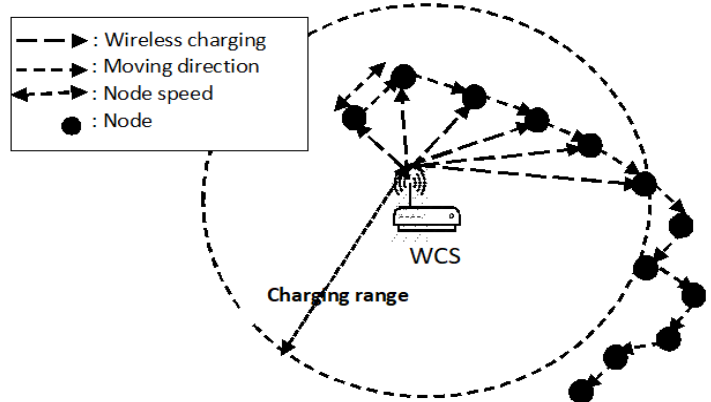
Figure 2. Wireless Charging Station (WCS) with Mobile Nodes. A node continuously receives energy once it is within the charging coverage of the WCS.